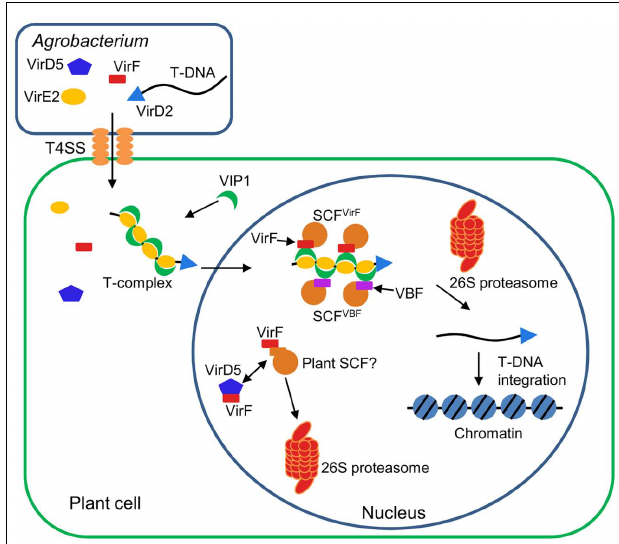
FIGURE 3 | Involvement of F-box proteins in Agrobacterium infection. Agrobacterium exports a single-stranded copy ofT-DNA (T-strand) as well as virulence (Vir) effector proteins into plant cell.Within plant cell,T-strand is assembled into a nucleoprotein complex (T-complex) in which oneVirD2 molecule is attached to the 5 (cid:2) end of theT-strand and multipleVirE2 molecules coat the entire length of theT-strand. In addition, the plant factor VIP1 directly interacts withVirE2 and guides theT-complex into the host cell nucleus. Once theT-complex enters the nucleus, it is presumably disassembled by an SCF complex containingVirF as an F-box component. The SCF VirF complex mediates polyubiquitination ofVIP1, thereby targeting VIP1 as well as its associatedVirE2 for 26S proteasome-dependent degradation. In plant species that do not requireVirF for full virulence, Agrobacterium most likely also utilizes the host F-box proteinVBF for the T-complex uncoating. As a defense strategy, the host plants destabilizeVirF via the ubiquitin/26S proteasome system (UPS), presumably using an as yet unidentified plant SCF complex. Another exported effector,VirD5, counteracts this host-induced degradation ofVirF by directly binding to and